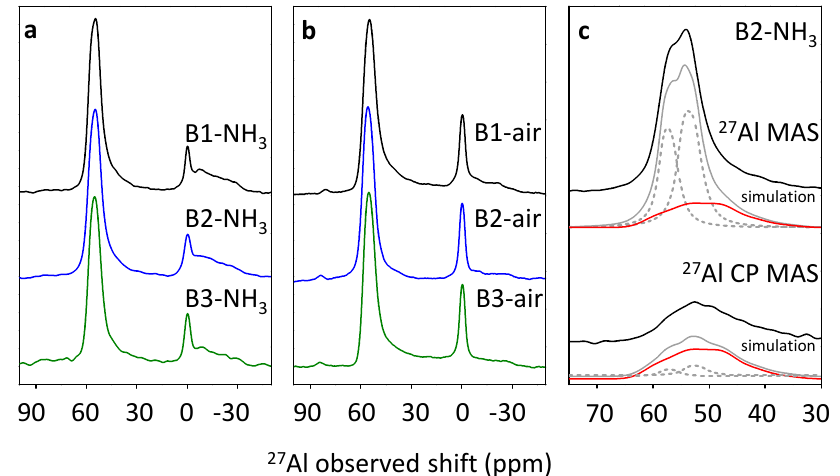
Figure 5. 27 Al MAS NMR spectra of hydrated B1 ‐ B3 samples calcined in ammonia ( a ) and in air ( b ). 27 Al MAS NMR and 27 Al CP MAS NMR spectra of B2 ‐ NH 3 sample black solid lines, together with spectra simulation ( c ) gray and red lines.